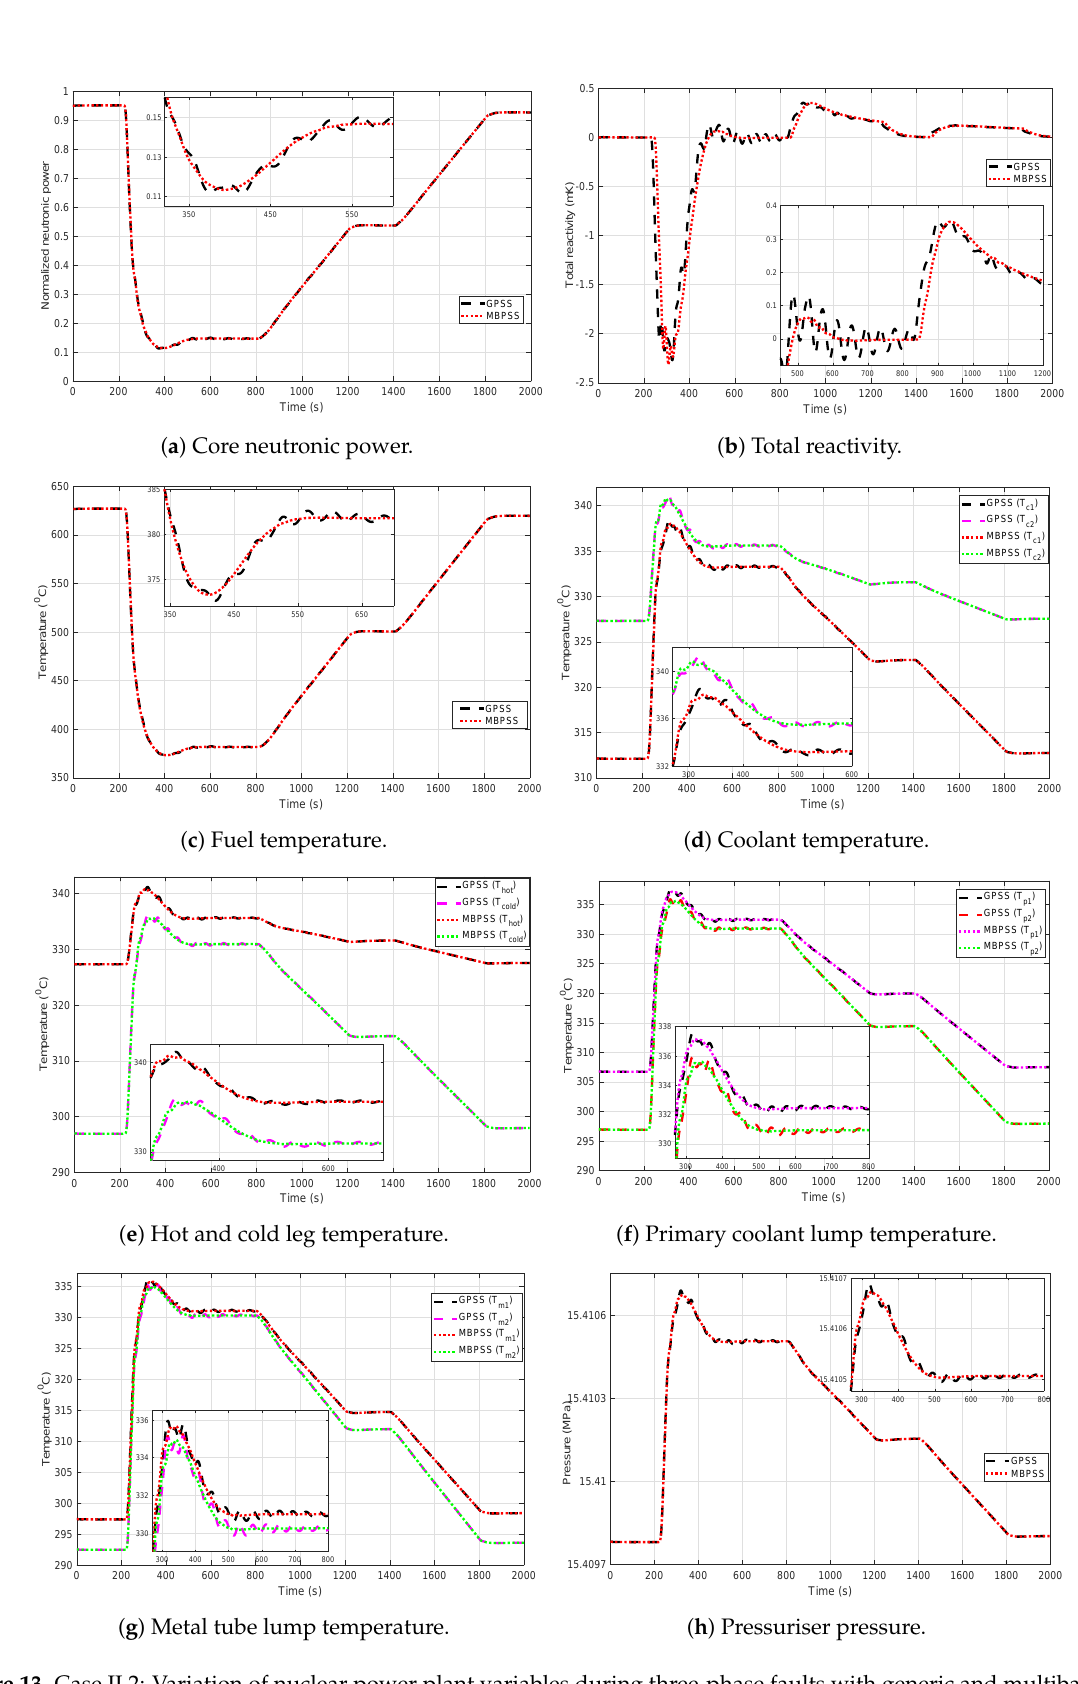
Figure 13. Case II.2: Variation of nuclear power plant variables during three-phase faults with generic and multiband PSS with